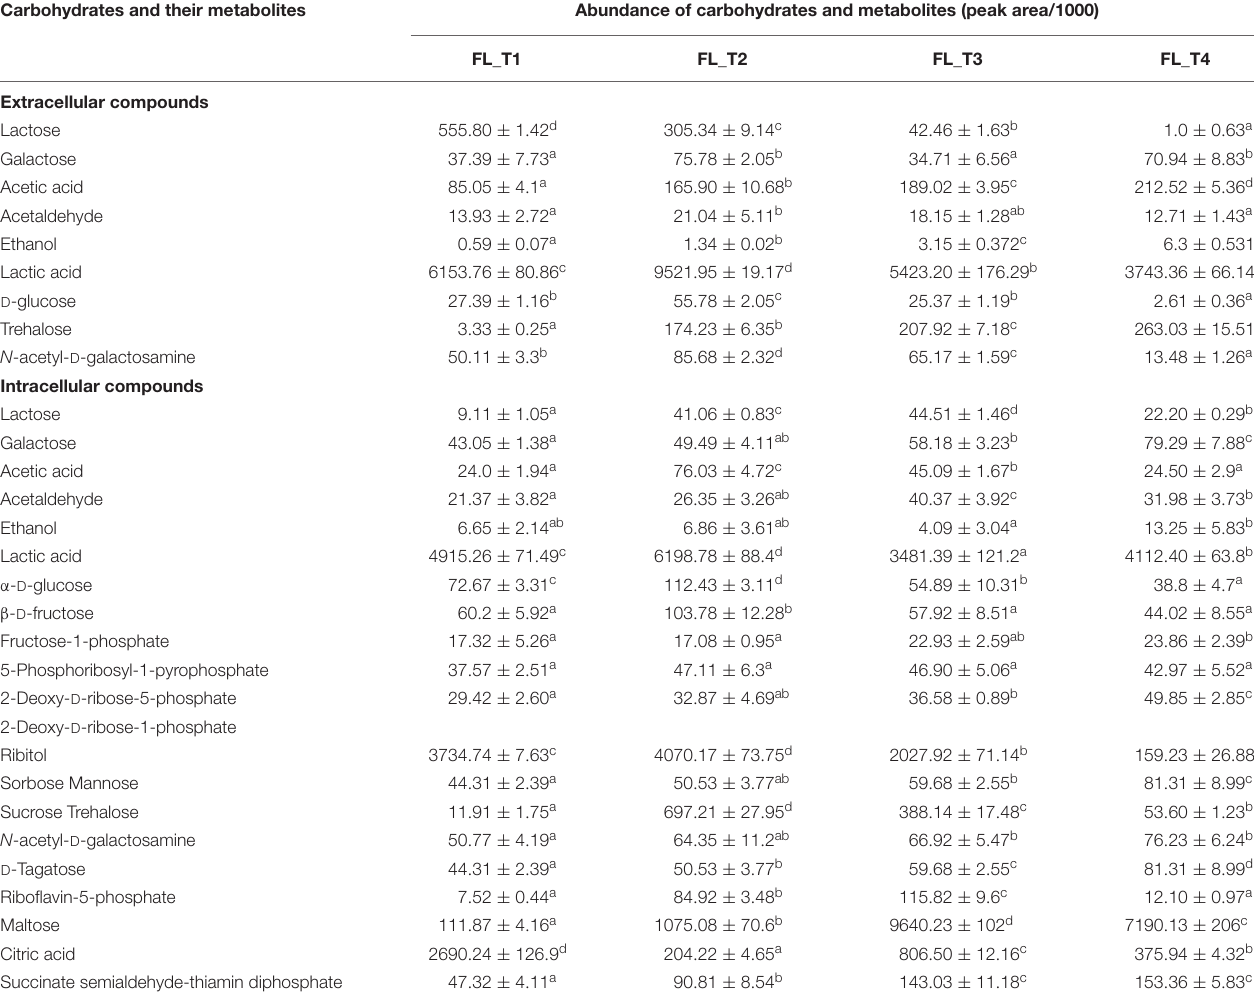
TABLE 1 | Changes in the concentrations of carbohydrates and their metabolites during ST-MZ-2 culture. Carbohydrates and their